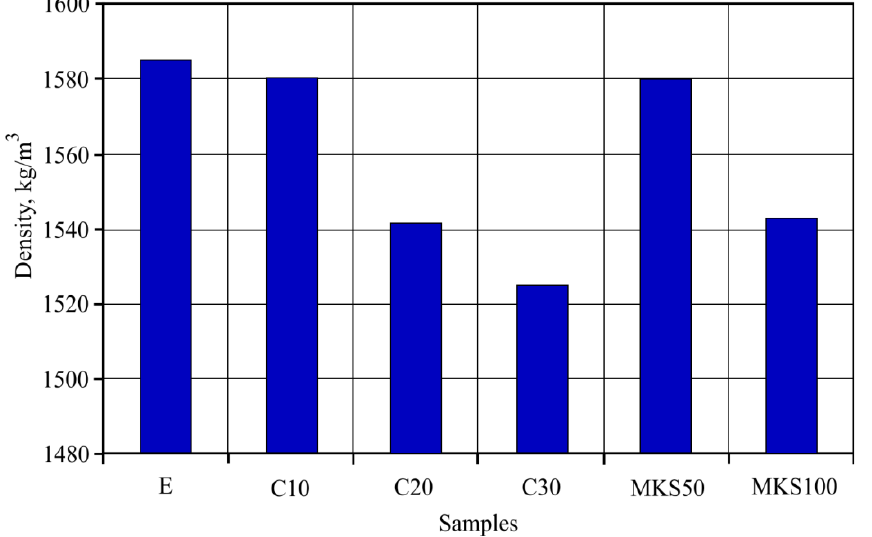
Figure 8. Researched sample dry density results.